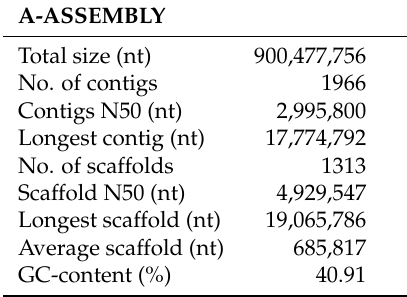
Table 2. Summary statistics of Sander lucioperca genome assembly and